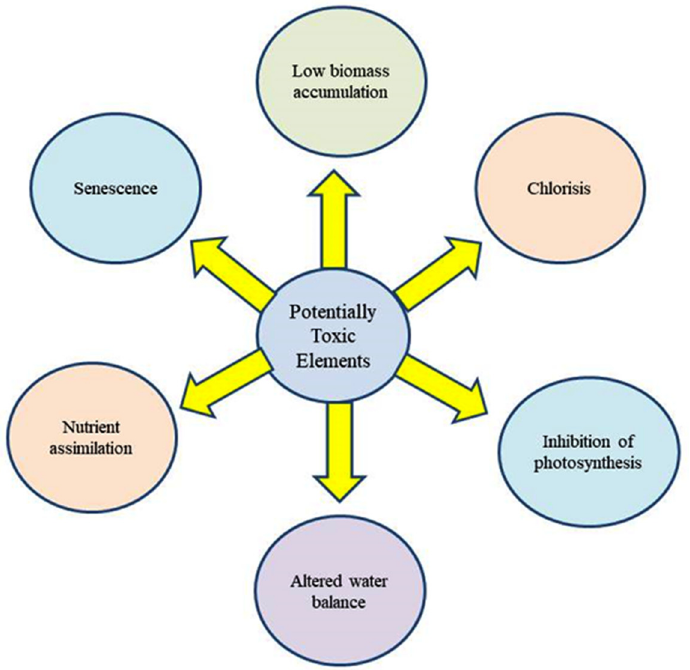
Figure 3. Major toxic effects of PTEs on plants. The main entry points for PTE ions into plant systems are the leaves and roots. High PTE concentrations have detrimental effects, including the inhibition of cytoplasmic en-